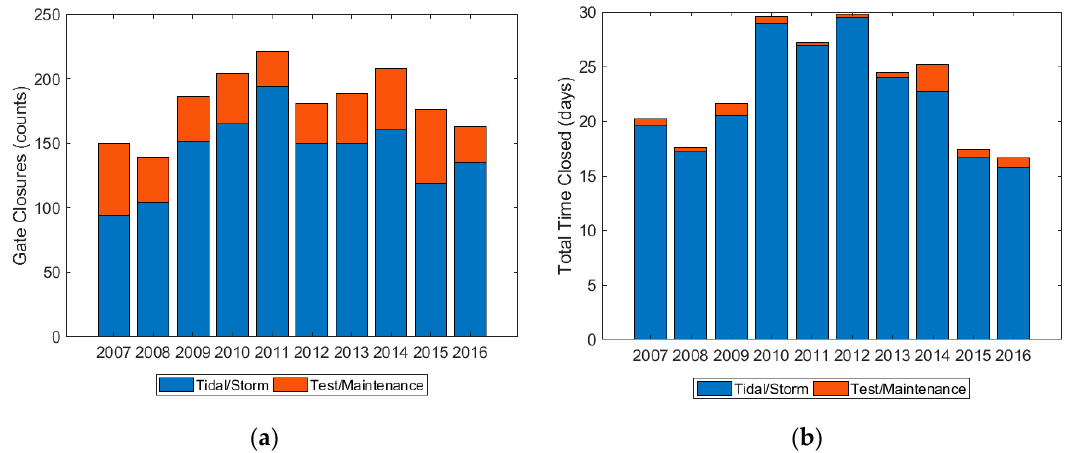
Figure 4. Number of gate closures ( a ) and total time closed ( b ) per year for 2007 to 2016.